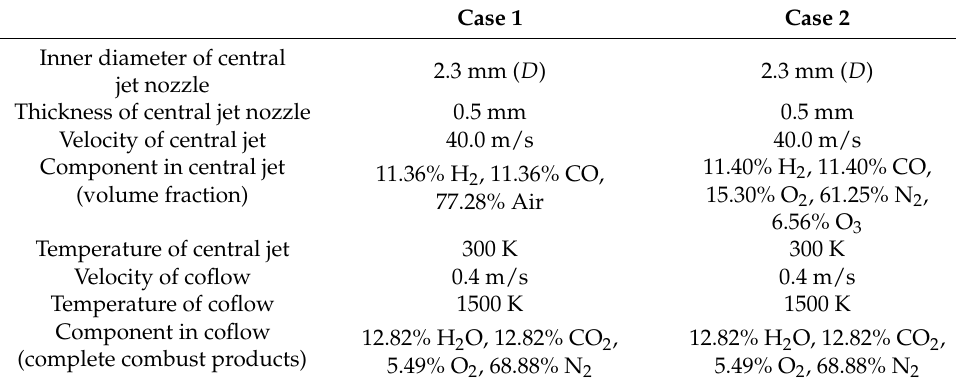
Table 1. The parameters of the two cases.